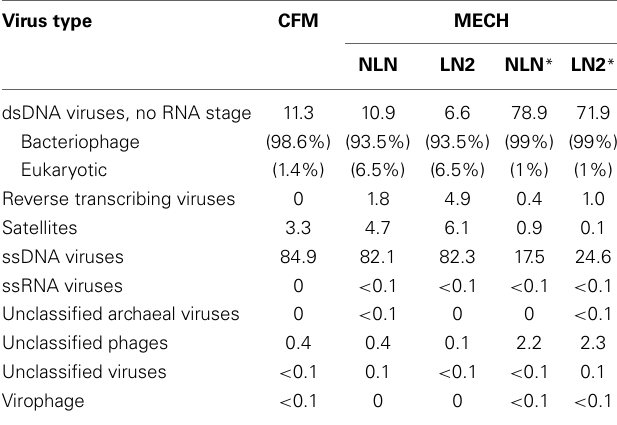
Table 1 | Percentage of viruses identified in DNA viromes by BLAST comparison to the NCBI viral Refseq genome database (bit-score = 50, GAAS